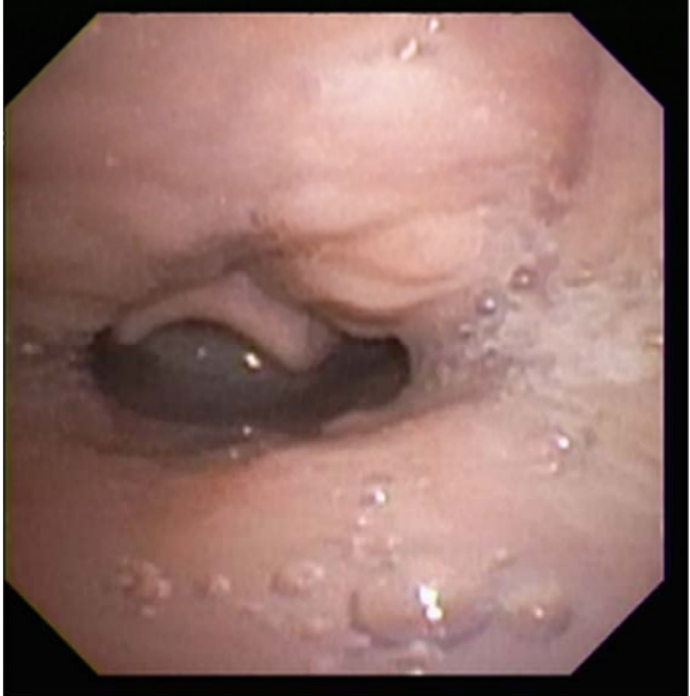
Figure 7. Sleep endoscopy image demonstrating tongue-base obstruction. Note the tongue base in contact with the epiglottis, which is prolapsed over the